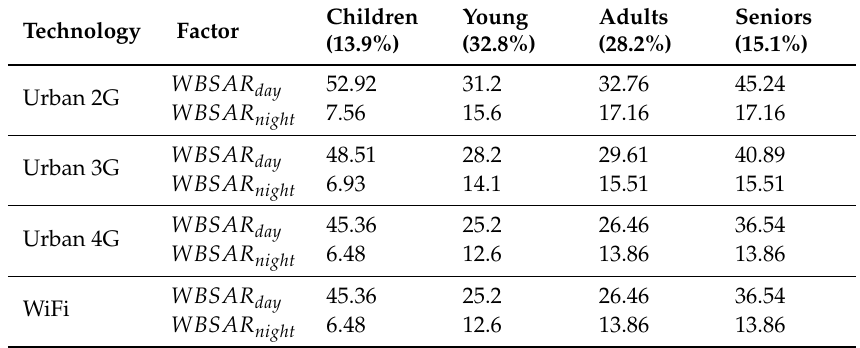
Table 4. Outdoor average Whole Body SAR (WBSAR) according to population segment and technology.